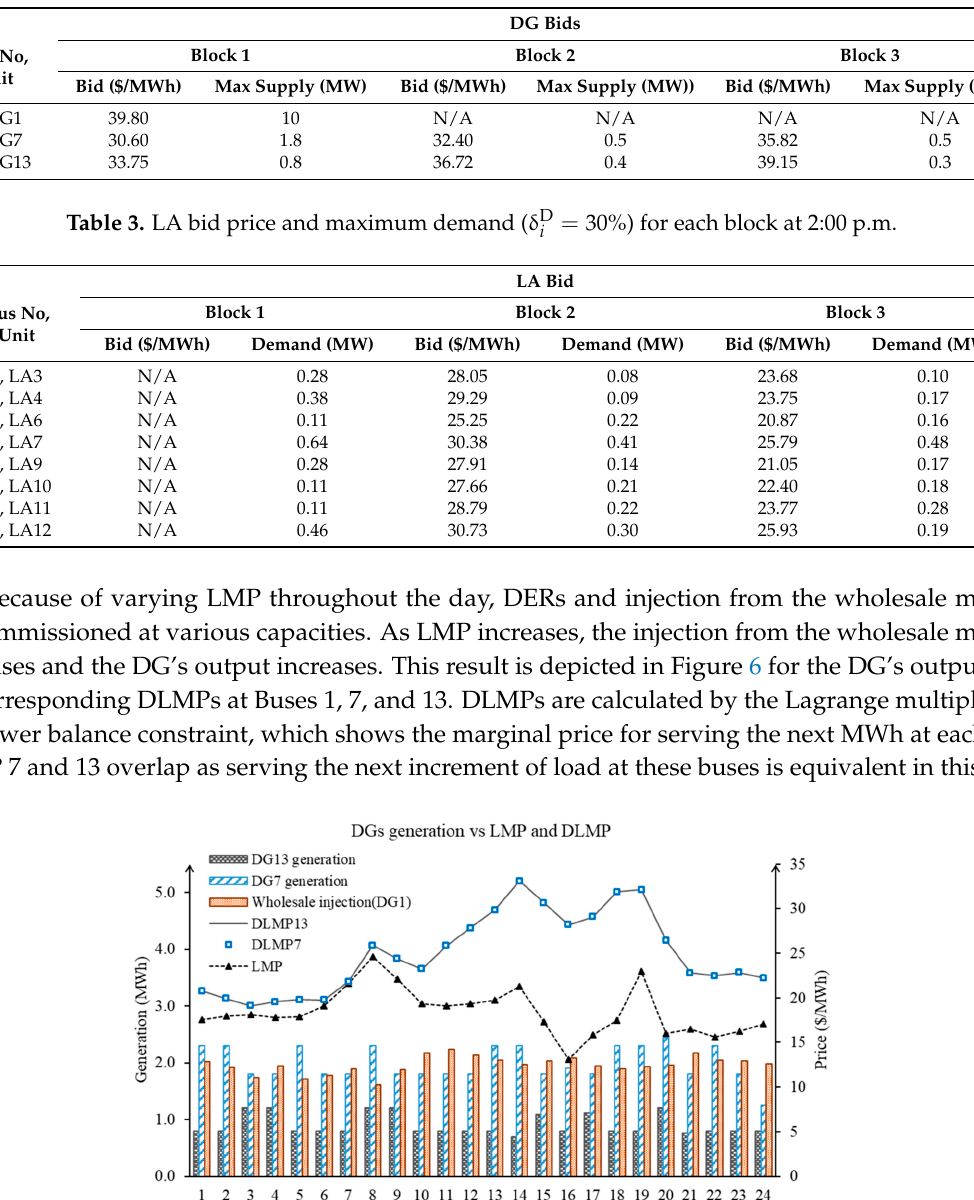
= ± 30%) for each block at 2:00 p.m. i